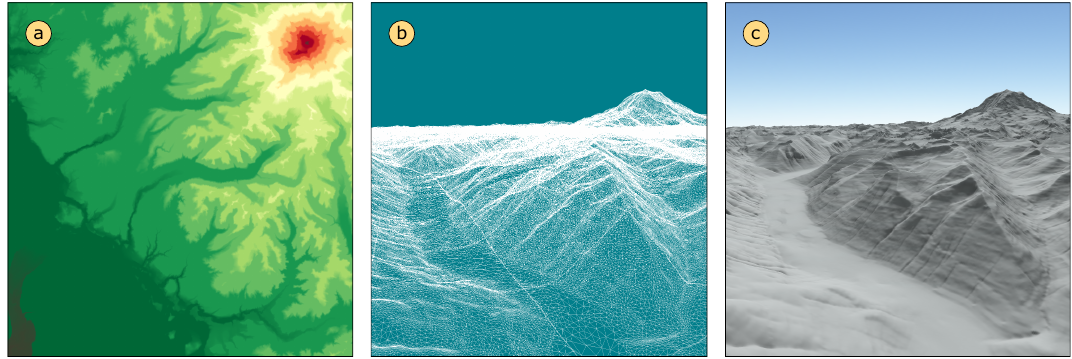
Figure 1. Visualizing 3D terrain. The terrain model is typically based on height-field data ( a ) from which triangular networks are generated ( b ) before the final model is rendered ( c ).